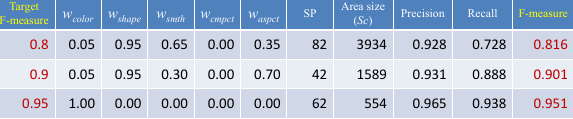
Table 2. Estimated optimum combination of parameters in different